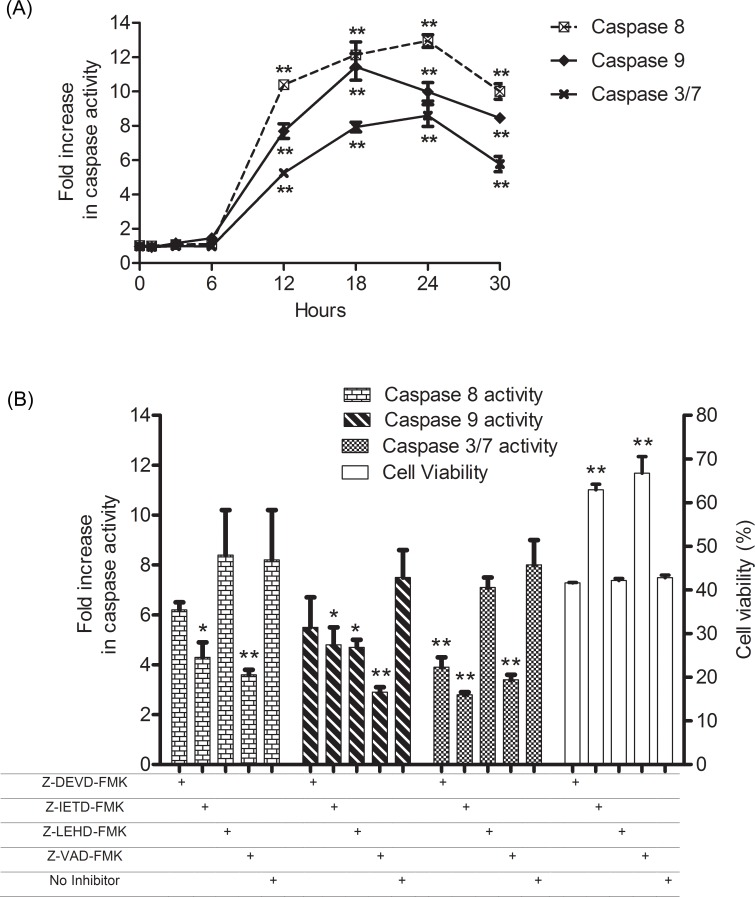
Fold changes in caspase activities and cell viability of treated HT-29 cells with respect to untreated control.(A) Time course (0–30 hours) fold increase in caspase 3/7, 8 and 9 activities of HT-29 cells post-treatment with the cycloartane (50 μM). (B) Effects of caspase inhibitors on treated HT-29 cells. Changes in caspase 3/7, 8 and 9 activities, and cell viability of cells pre-treated with caspase 3 inhibitor (Z-DEVD-FMK), caspase 8 inhibitor (Z-IETD-FMK), caspase 9 inhibitor (Z-LEHD-FMK) or general caspase inhibitor (Z-VAD-FMK), followed by incubation with the cycloartane (50 μM). At 18 hours of treatment, caspase activities were determined, and at 24 hours of treatment cell viability was measured. All results are three independent determinations with fold increases and percent cell viabilities calculated based on the untreated control. Symbols indicate significantly higher compared to 0 hour or no inhibitor pre-treatment: *p < 0.05; **p < 0.01.